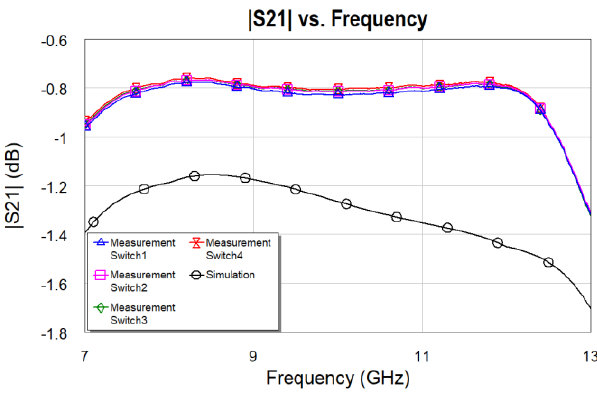
Figure 23: Insertion Loss for the designed switch. Black line simulation. Other lines measurement